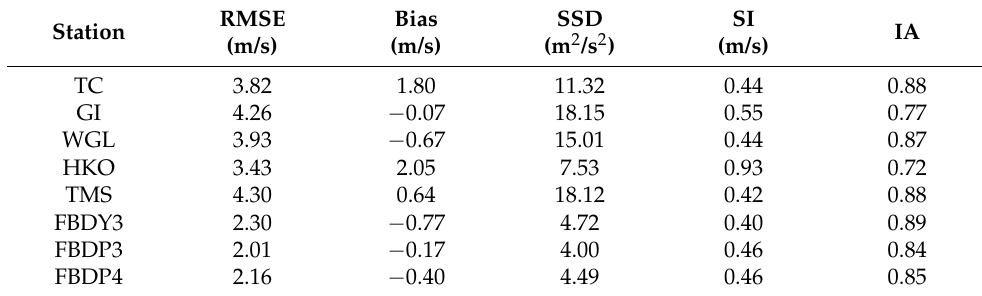
Table 5. Summary of the error indicators for the wind speed simulation.